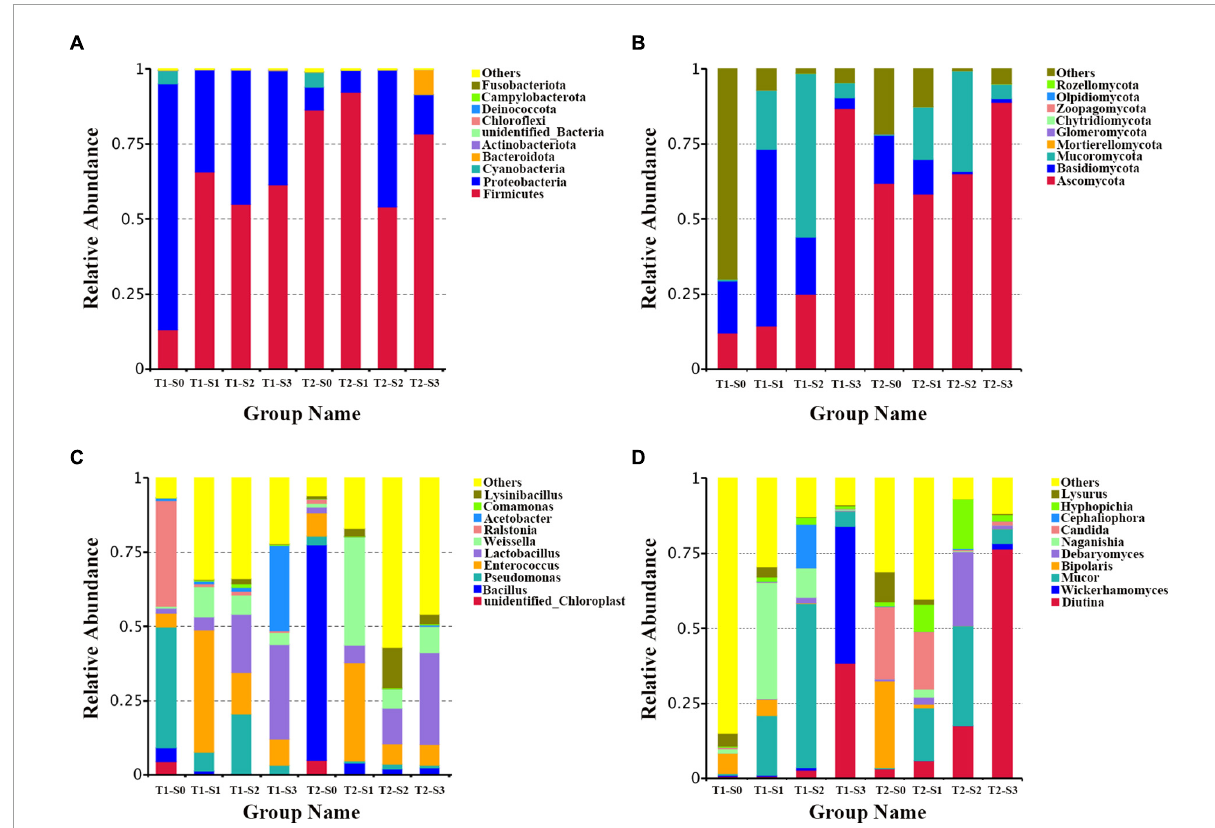
FIGURE2 The composition of bacterial and fungal communities in fermented rapeseed cake. (A) The histogram of bacterial composition in fermented rapeseed cake at the phylum level. (B) The histogram of fungal composition in fermented rapeseed cake at the phylum level. (C) The histogram of bacterial composition in fermented rapeseed cake at the genus level. (D) The histogram of fungal composition in fermented rapeseed cake at the genus